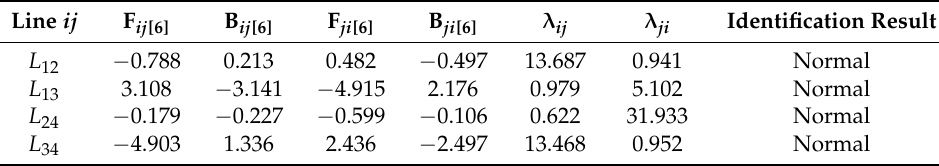
Table 4. Identification results of faulted segment for f 4